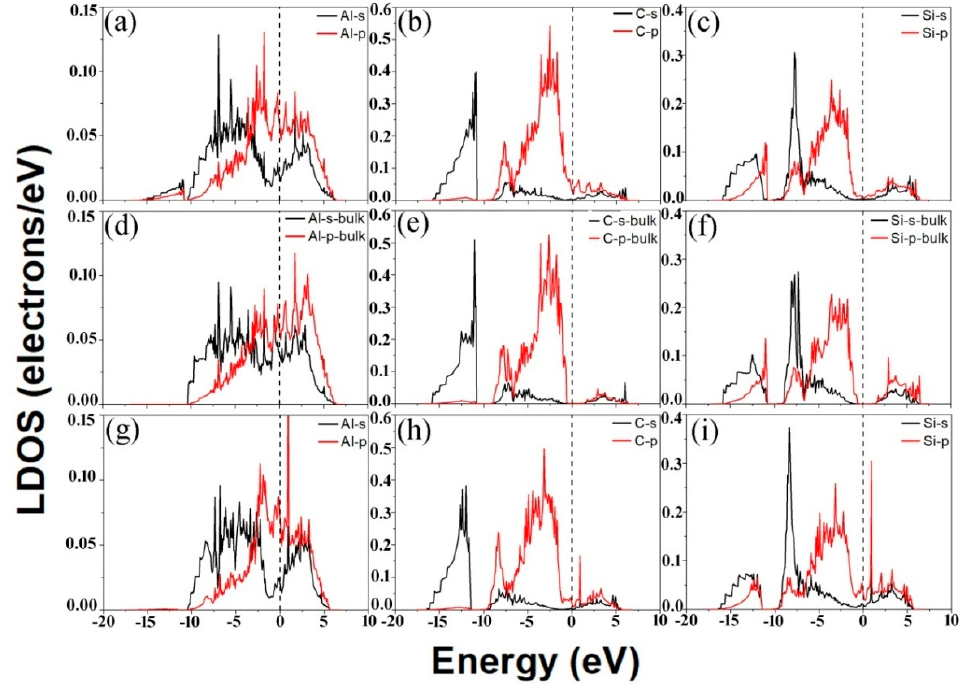
Figure 3. Local electronic density of state (LDOS) of the TOP site of the C-terminated ( a – c ) and the Si-terminated ( g – i ) Al (111) / 6H-SiC (0001) interface. For comparative purposes, the LDOS of the bulk of Al ( d ) and SiC ( e , f ) are shown. As shown in the dotted line, the Fermi energy shifted to 0 eV. Black and red solid lines represent densities of state of the s and p orbital electrons, respectively.